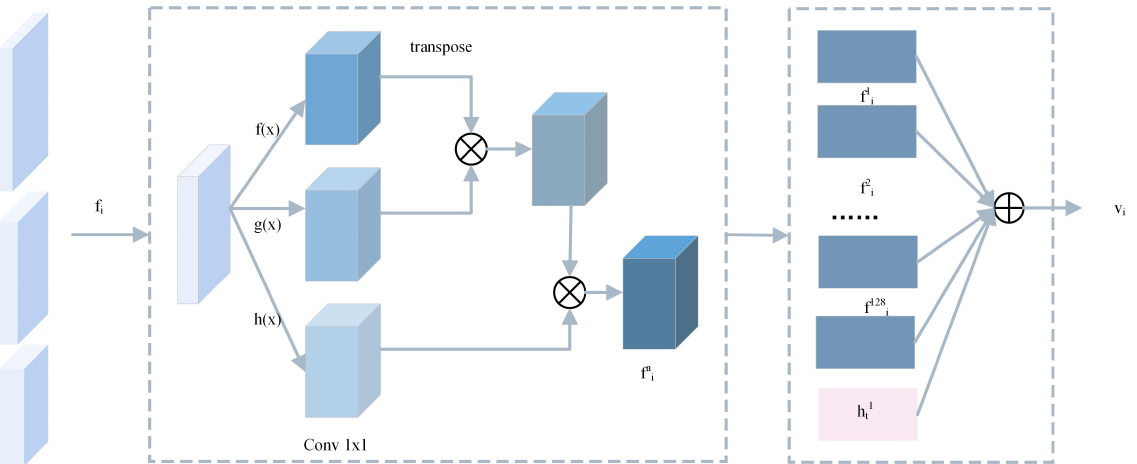
Figure 2. Overview of the Image-Enhance module. This module’s hierarchical attention mechanism is primarily made up of two distinct attention mechanisms. The self-attention mechanism is the first layer of the attention mechanism, and it uses pixels at all positions in different visual features f i to obtain detailed information f a , as shown in the first dotted box. The second layer of the attention i mechanism is additive attention to aggregate image information related to text, as shown in the second dotted box. The two attention mechanisms work together to implement the concept of hierarchical